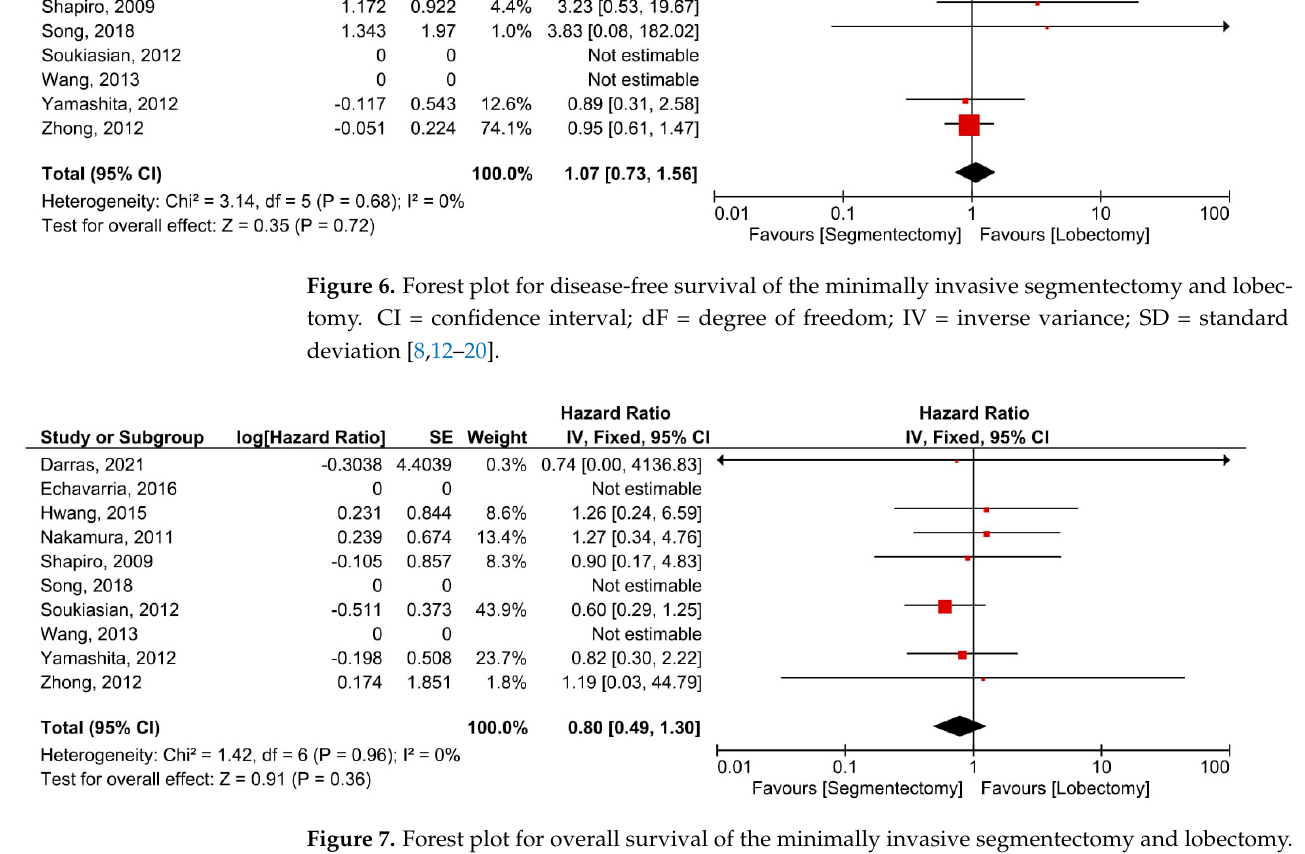
Figure 7. Forest plot for overall survival of the minimally invasive segmentectomy and lobectomy. CI = confidence interval; dF = degree of freedom; IV = inverse variance; SD = standard deviation [8,12–20].